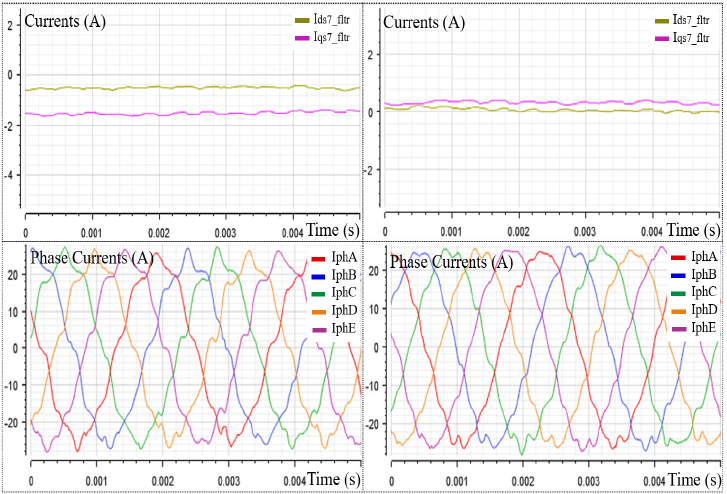
Figure 16. Minimization of the 7th harmonic impact in healthy condition: before ( left ) and after ( right ), 25A-25600RPM operating point.